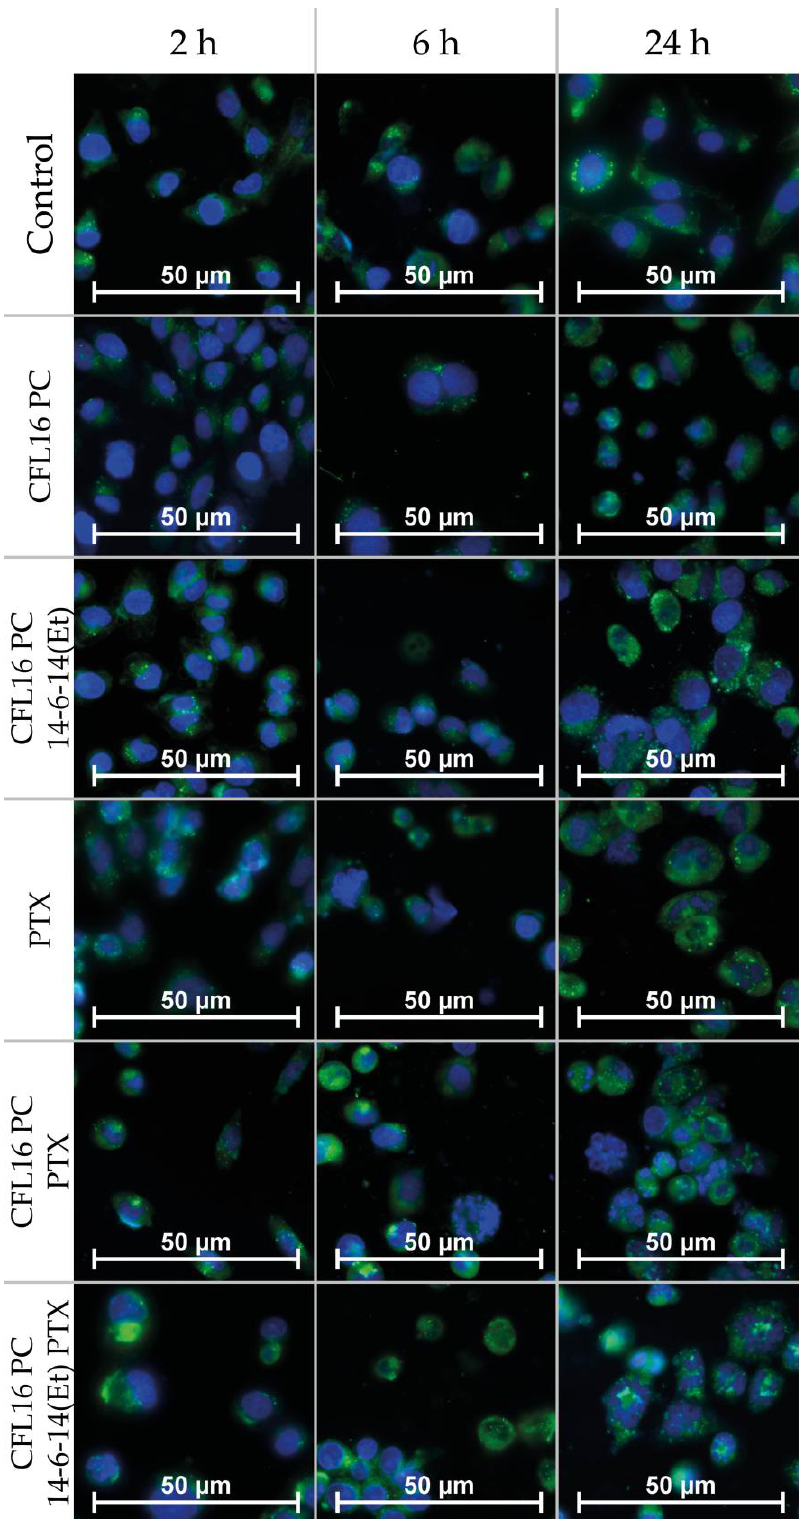
Figure 6. Internalization of CFL PC 1:1 cerasomes into T98G cells at 2, 6 and 24 h after incubation visualized with fluorescence microscopy. Green channel is coumarin 6 and blue channel is DAPI. Separate channel microphotographs are provided in Section S3 of the Supplementary Information.